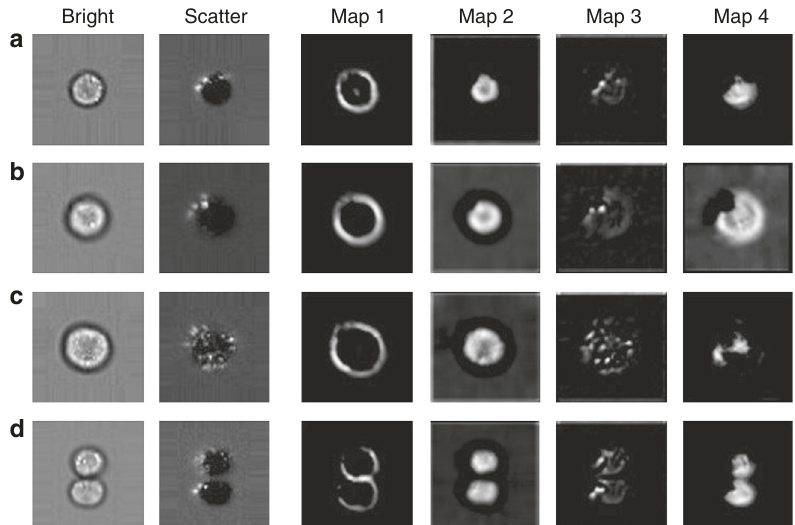
Fig. 4 Exemplary activation patterns of intermediate layers. Plotted are activations after the second convolutional module for examples of single cells from four different phases: a G1, b G2, c Anaphase, and d Telophase. The response maps mark regions of high activation. Map 1 responds to the cell boundaries. Map 2 responds to the internal area of the cells. Map 3 extracts the localized scatter intensities. Map 4 constitutes a cross-channel feature, which correlates with the difference of map 2 and 3